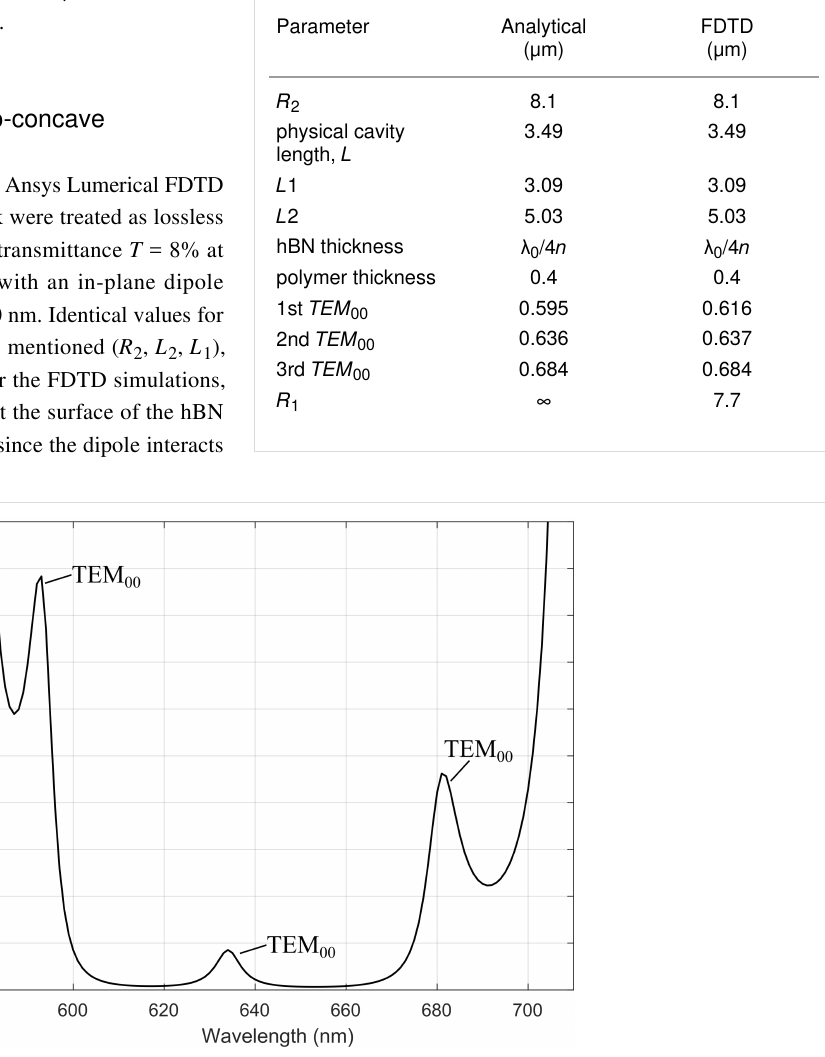
Table 1: Geometrical parameters and fundamental TEM mode values of the designed hybrid plano-concave